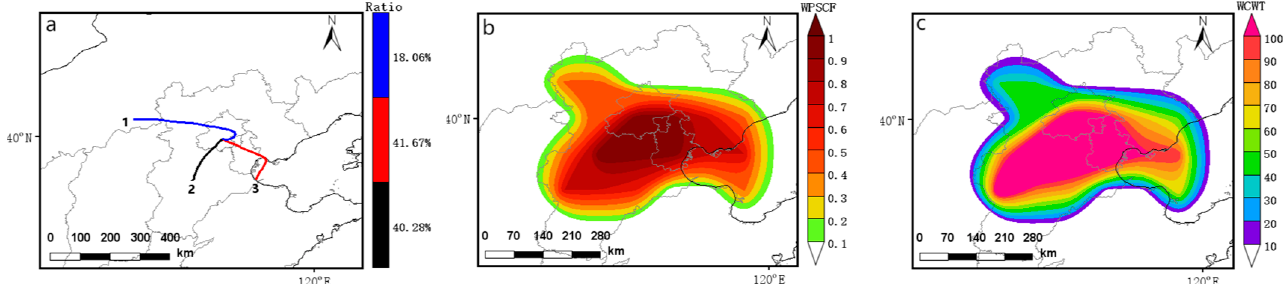
Figure 15. Spatial distribution of clusters by backward air mass trajectories, WPSCF, and WCWT (( a ) Backward air mass trajectories; ( b ) WPSCF; ( c ) WCWT).